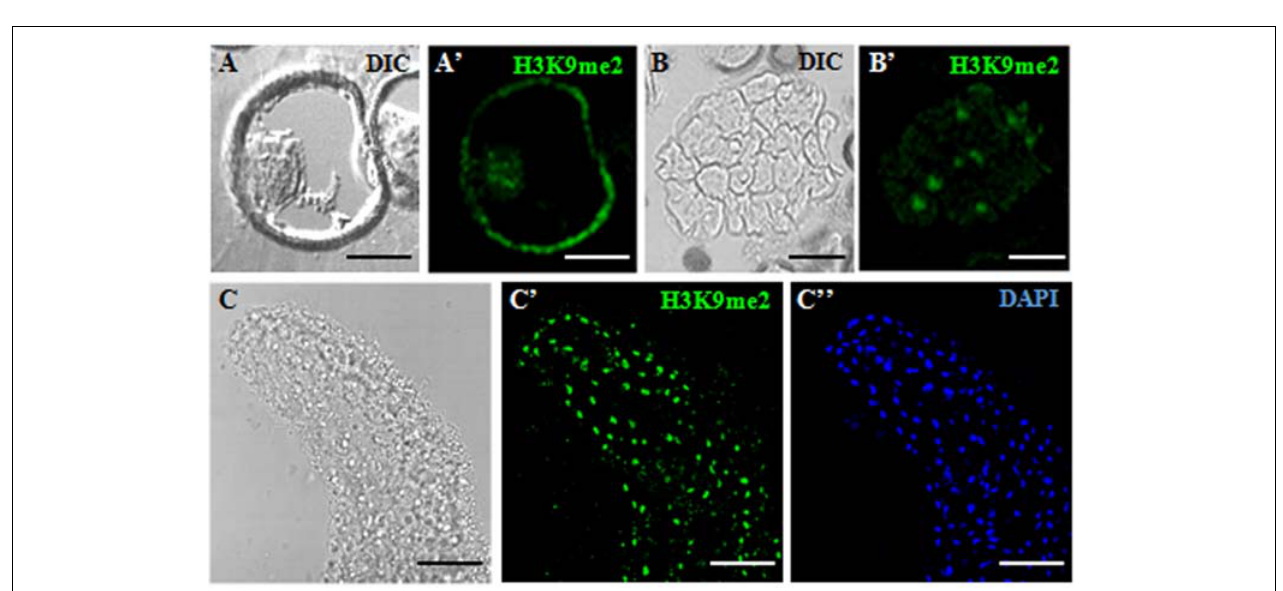
FIGURE 3 | Immunofluorescence of H3K9me2 during microspore embryogenesis initiation and progression of Brassica napus . Confocal laser scanning microscopy analysis of vacuolated microspores (A,A’) , proembryos (B,B’) and cotyledonary embryos (C–C”) . (A–C) : Nomarsky’s differential interference contrast (DIC) images showing the cellular organization of the different structures. (A’–C’) : H3K9me2 immunofluorescence signal over nuclei (green). (C”) : DAPI staining of nuclei (blue) of a region of the cotyledon. The same structures are visualized under different microscopy modes in ( A,A’) , (B,B’) and (C–C”) . The exine showed unspecific autofluorescence in some images (A’) . Bars represent: (A,A’) : 10 µ m, (B,B’) : 20 µ m, (C–C”) : 50 µ